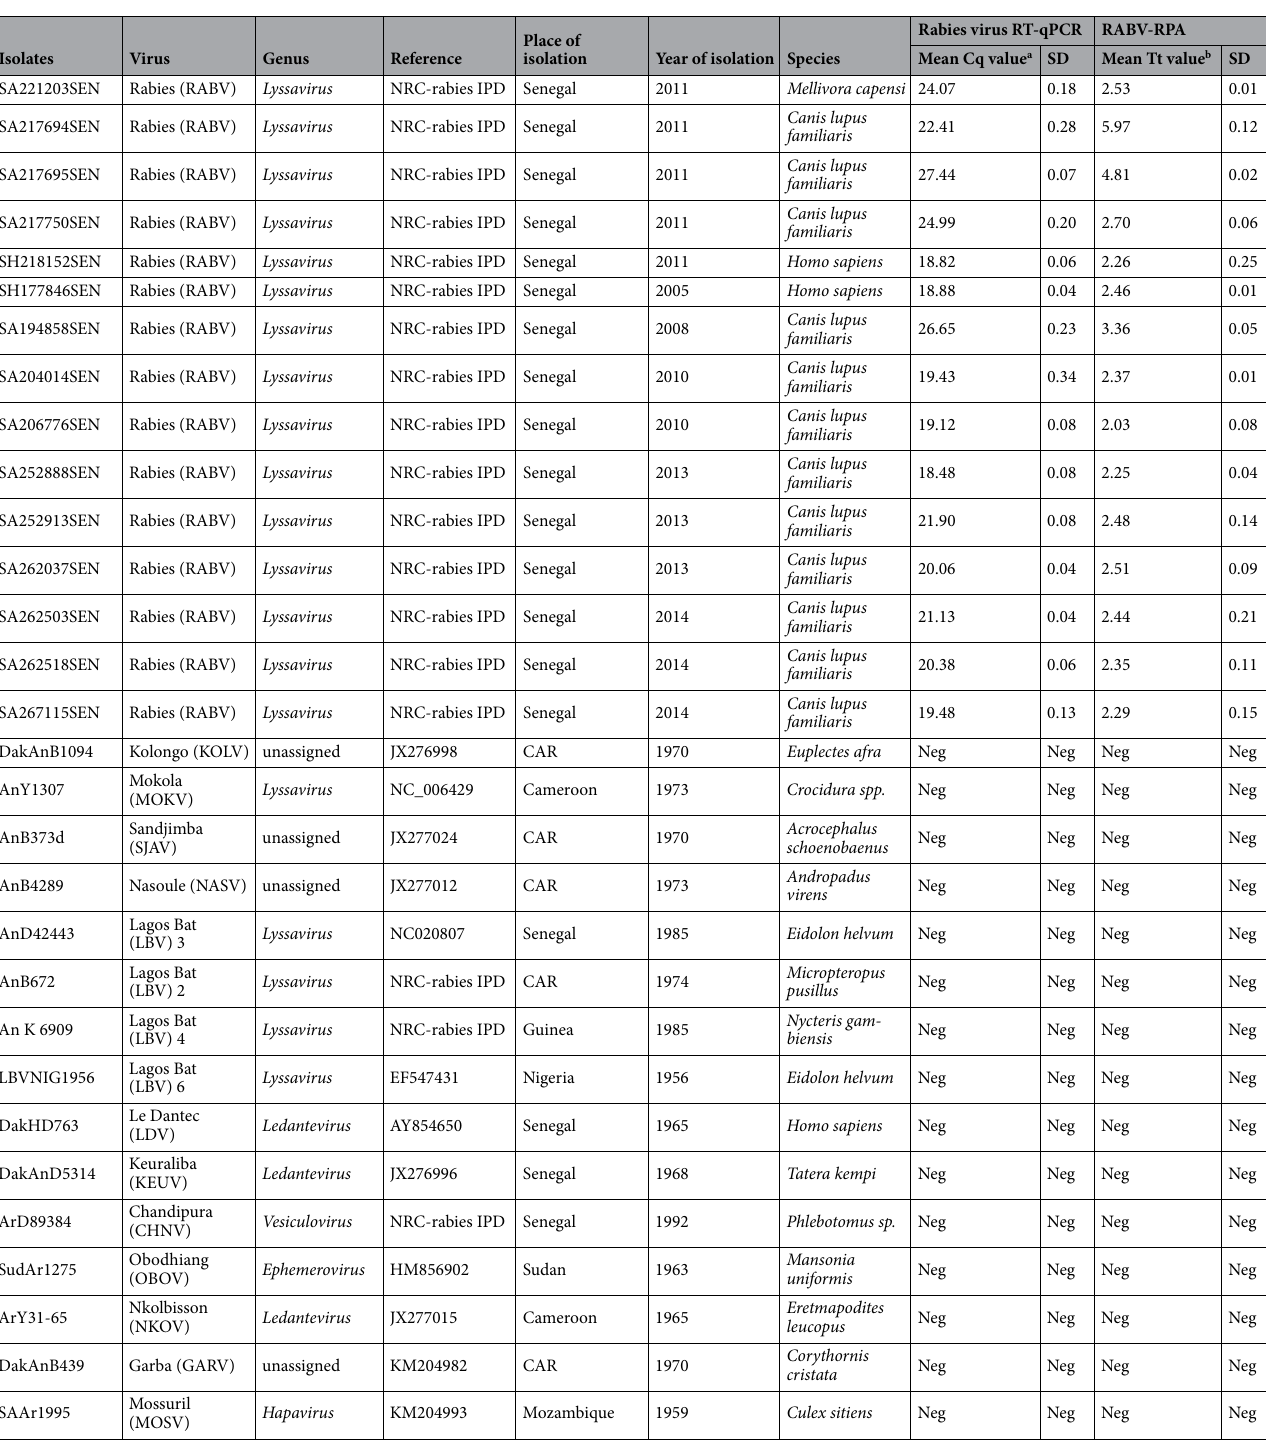
Table 1. Description and results of rhabdoviruses isolates used in this study for specificity assessment. Tt: time threshold in minutes, CAR: Central African Republic, SD: standard deviation, Neg: negative; no cross- reactivity, Cq: quantitative cycle, NRC-Rabies IPD: national reference center for rabies virus (NRC-Rabies) at Institut Pasteur de Dakar, BP 220, Dakar, Senegal. a Mean Cq value from duplicates with the